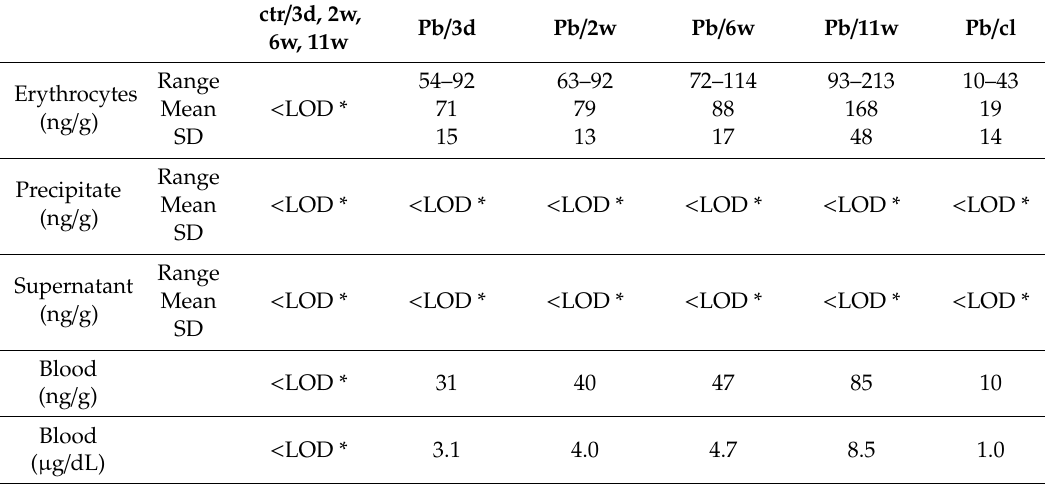
Table 3. Pb concentration in blood determined by